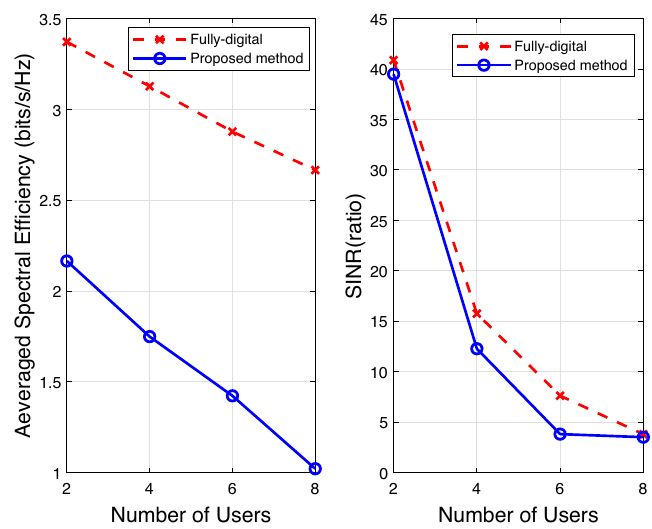
Fig. 8 The averaged spectral efficiency and radar SINR versus the number of users with N t = 64 , N RF t = 8 , 4 , η = 0.5 and SNR = 0 N cr = 4 , N rr = 32 , N RF r =